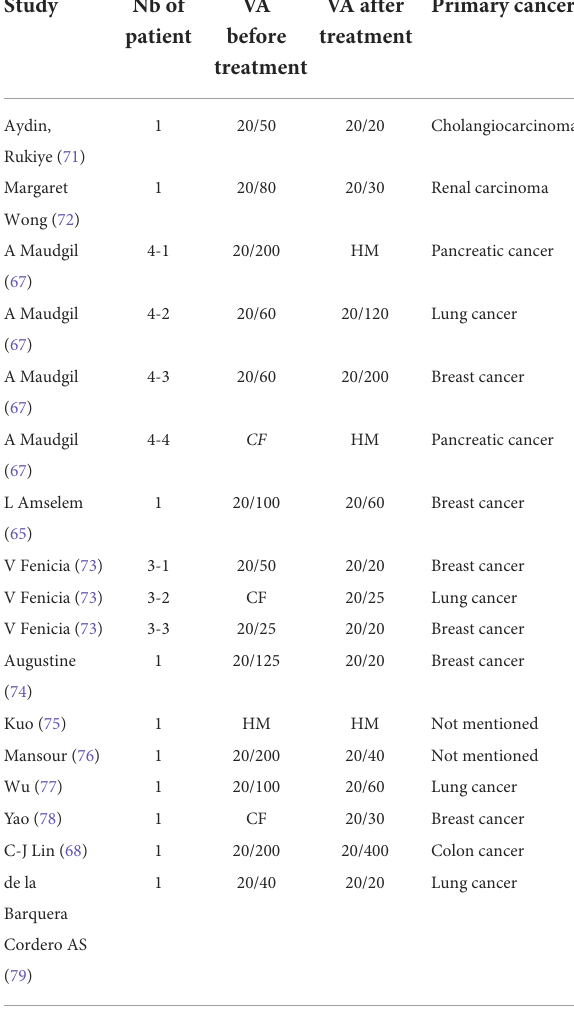
TABLE 2 Choroidal metastasis treated by